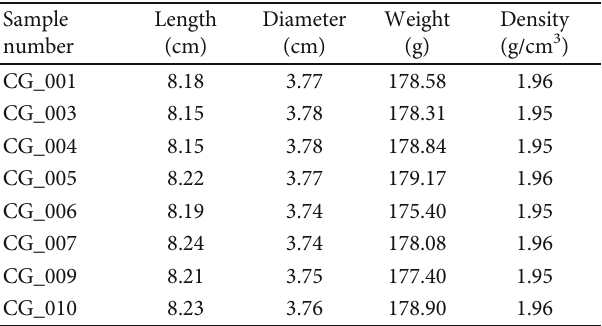
Figure 1: Photomicrograph of undeformed Castlegate sandstone. Table 1: Dimensions of Castlegate sandstone samples tested in this